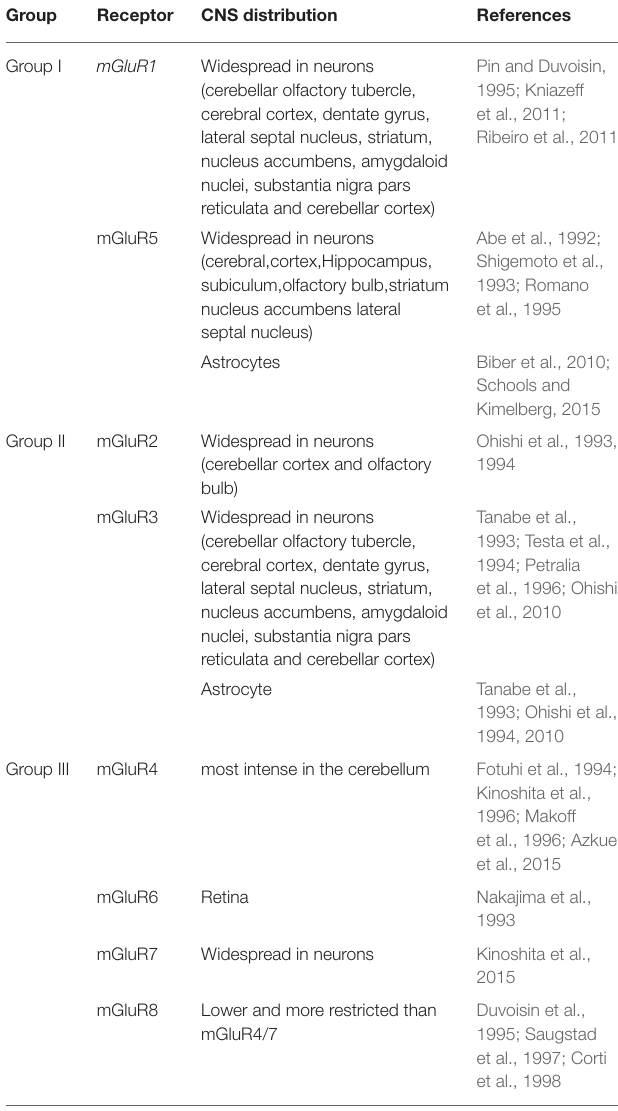
TABLE 1 | Distribution of mGluR in